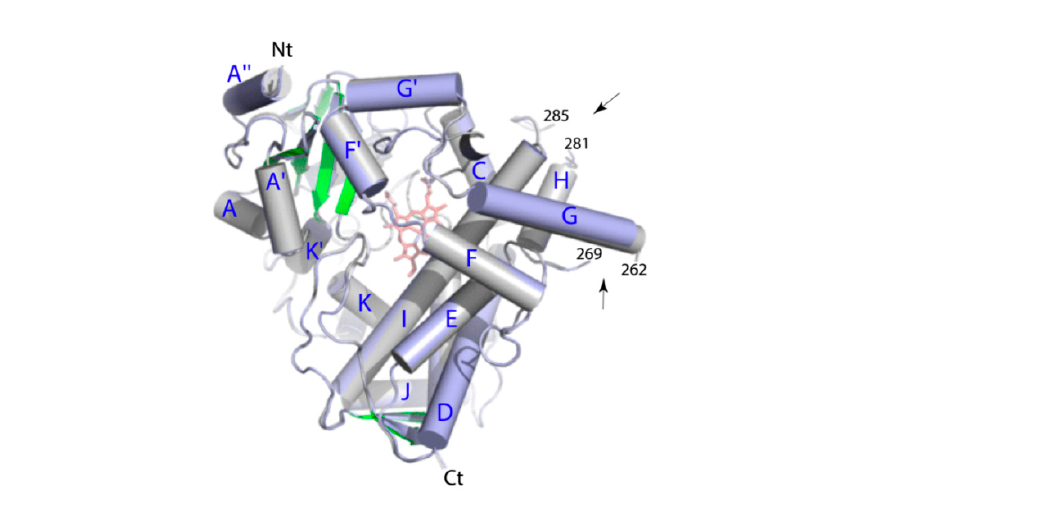
. Figure 4. Top ( A ) and side views ( B ) at the DTT molecule bound to the active site of CYP3A7 (mol- ecule A). DTT (in green sticks) binds above the heme and establishes water mediated H-bonds (red dotted lines) with the main chain atoms of A305, R372, and E374 and the heme iron. Red spheres and crosses are water molecules. Orange mesh around DTT is a simulated annealing omit map con- toured at 3 σ level; gray–cyan mesh is 2Fo-Fc electron density map contoured at 1 σ level. 2.4. Unique Features of CYP3A7 2.4.1. Divergence in the F-G Fragment CYP3A enzymes have high sequence identity (>82%) and share the same fold. When their 3D-structures are superimposed, the r.m.s. deviation between the C α atoms is 1.36 Å for both CYP3A4/3A7 and CYP3A5/3A7 pairs. The most notable difference is in the folding of the F-F ′ -G ′ -G helix/loop region (Figure 5), serving as an upper wall of the active site. In CYP3A7, the F-F ′ connector is shortened due to the F-helix extension, and its cen- tral F215, part of the phenylalanine cluster in CYP3A4 [22], is replaced with proline (Fig- ure 5A). Relative to CYP3A4/5, there is a lateral shift in the F ′ - and G ′ -helices and connect- ing loops (Figure 5B,C), likely triggered by the F304-centered cluster formation (explained below). As a result, the closely positioned F-F ′ and G ′ -G loops establish more intricate interactions, leading to partial immobilization and higher rigidity of the F-G fragment.